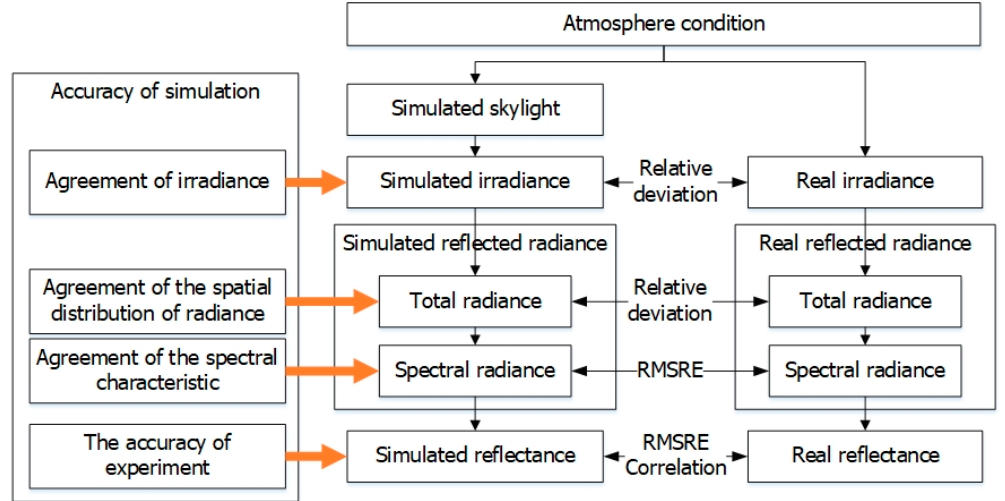
Figure 9. The flow chart of the experiment. RMSRE: root mean square relative error.